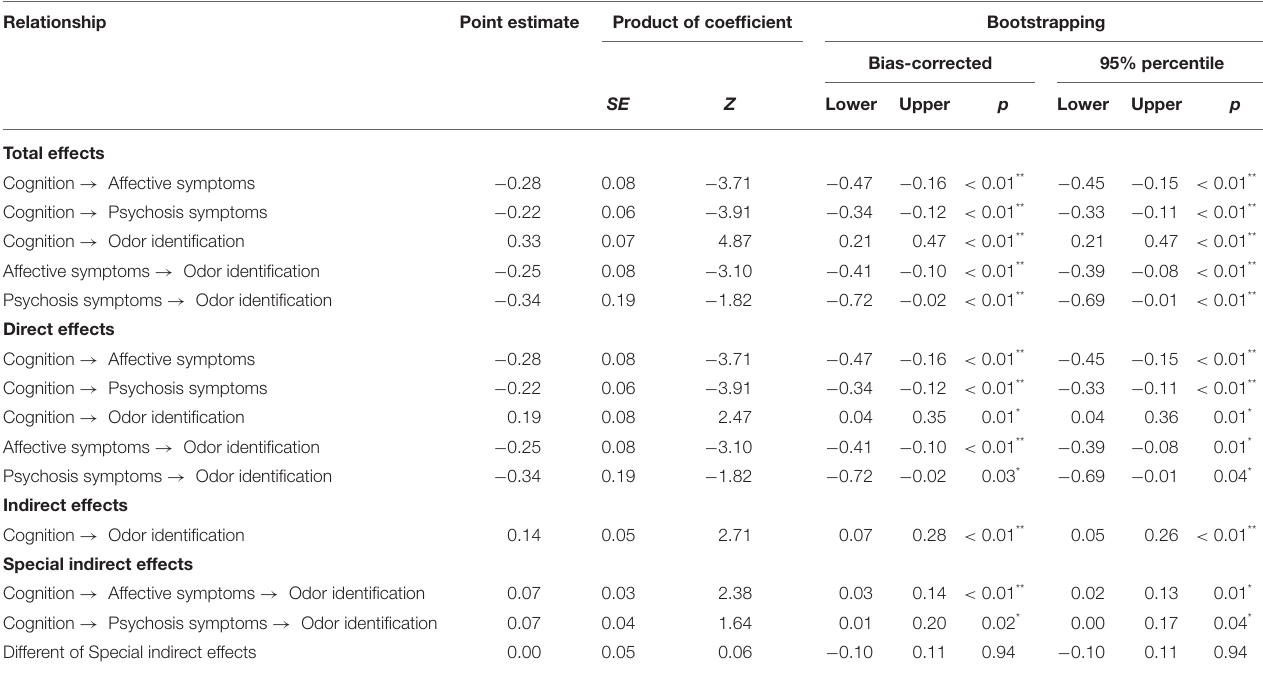
TABLE 5 | Unstandardized total, direct, indirect, and specific indirect effects of the mediation model ( N = 168). Relationship Point estimate Product of coefficient